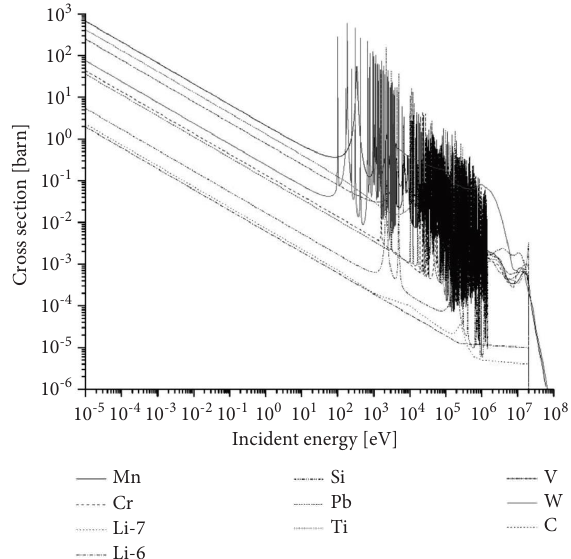
Figure 4: ( n, c ) reaction cross section as an absorption reaction in nuclides using ENDF/B-VII.1 [33].